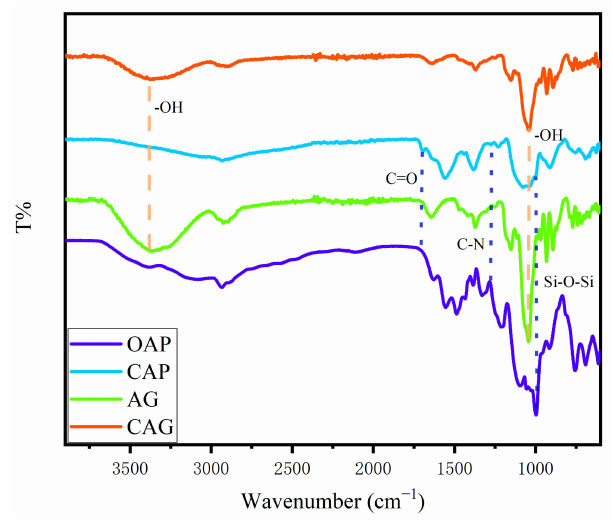
Figure 1. FTIR spectra for aminopropyl POSS (OAP), citric acid POSS (CAP), AG (freeze-dried AHG) and CAG (freeze-dried CAHG).